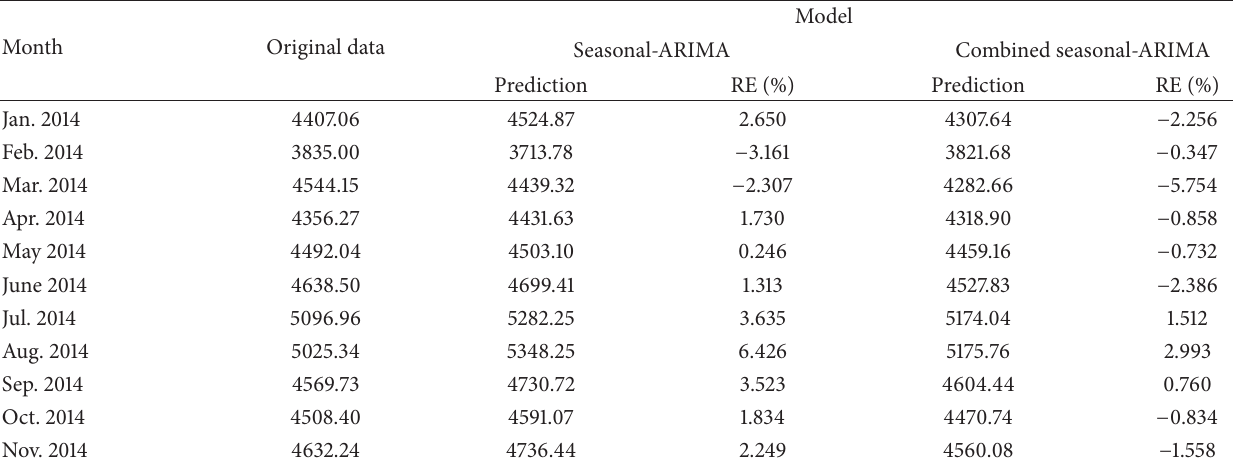
Table 6: Electricity consumption forecasting results in 2014.